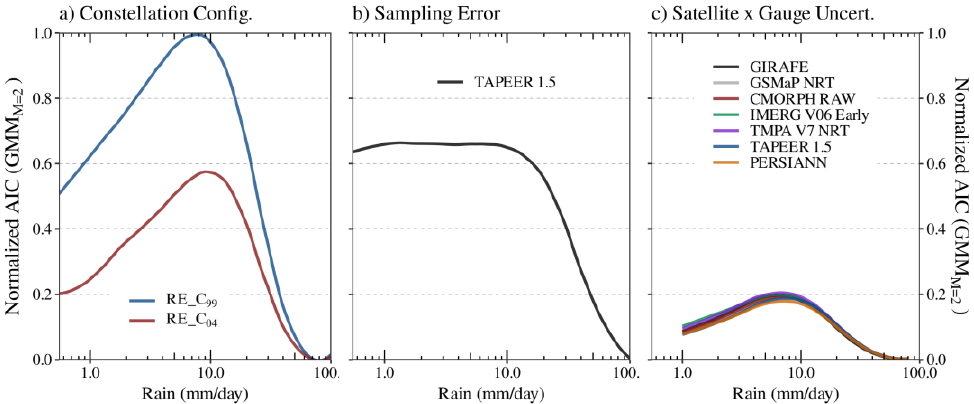
Figure 5. The GMM goodness-of-fit through the Akaike information criterion (AIC) statistics, as a function of the precipitation ( x -axis, in mm day −1 ). Comparisons between the three error sources considered: ( a ) due to constellation changes induced uncertainties, ( b ) due to sampling uncertainty and ( c ) through a comparison between multiple satellite-based with rain-gauges network. AIC results were normalized by the maximum value of all error sources.